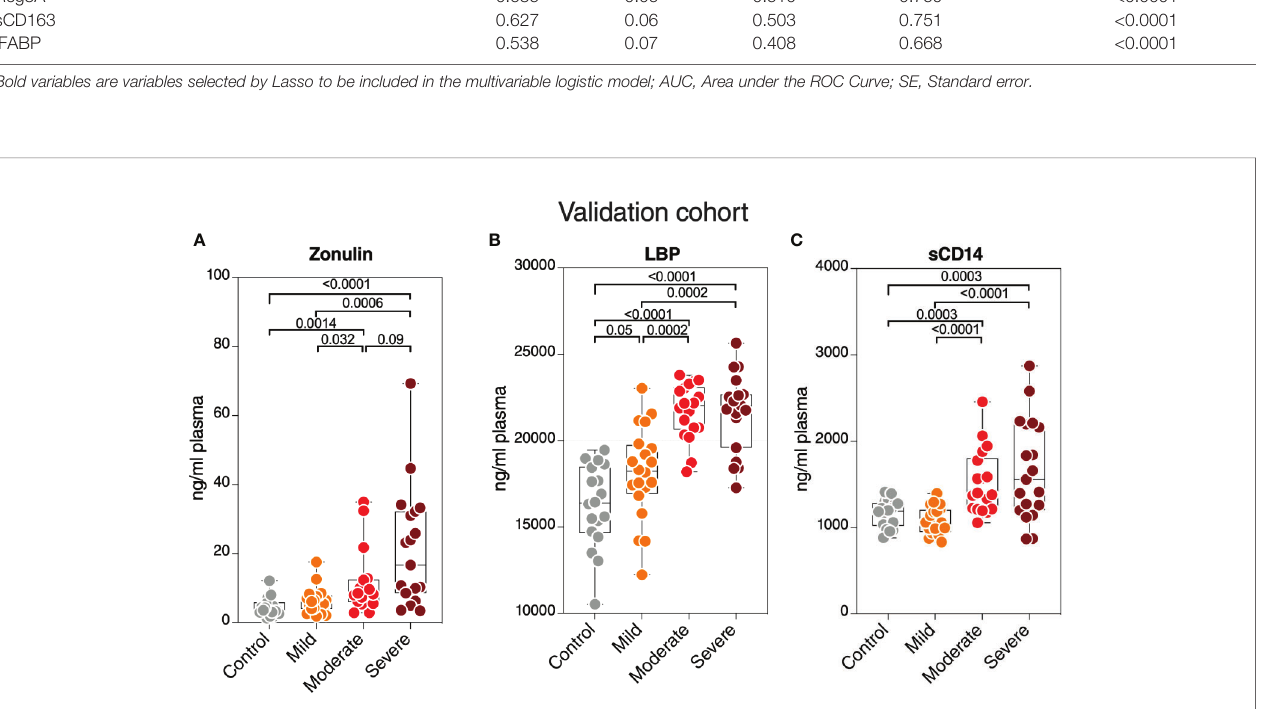
models vs. Lasso selected